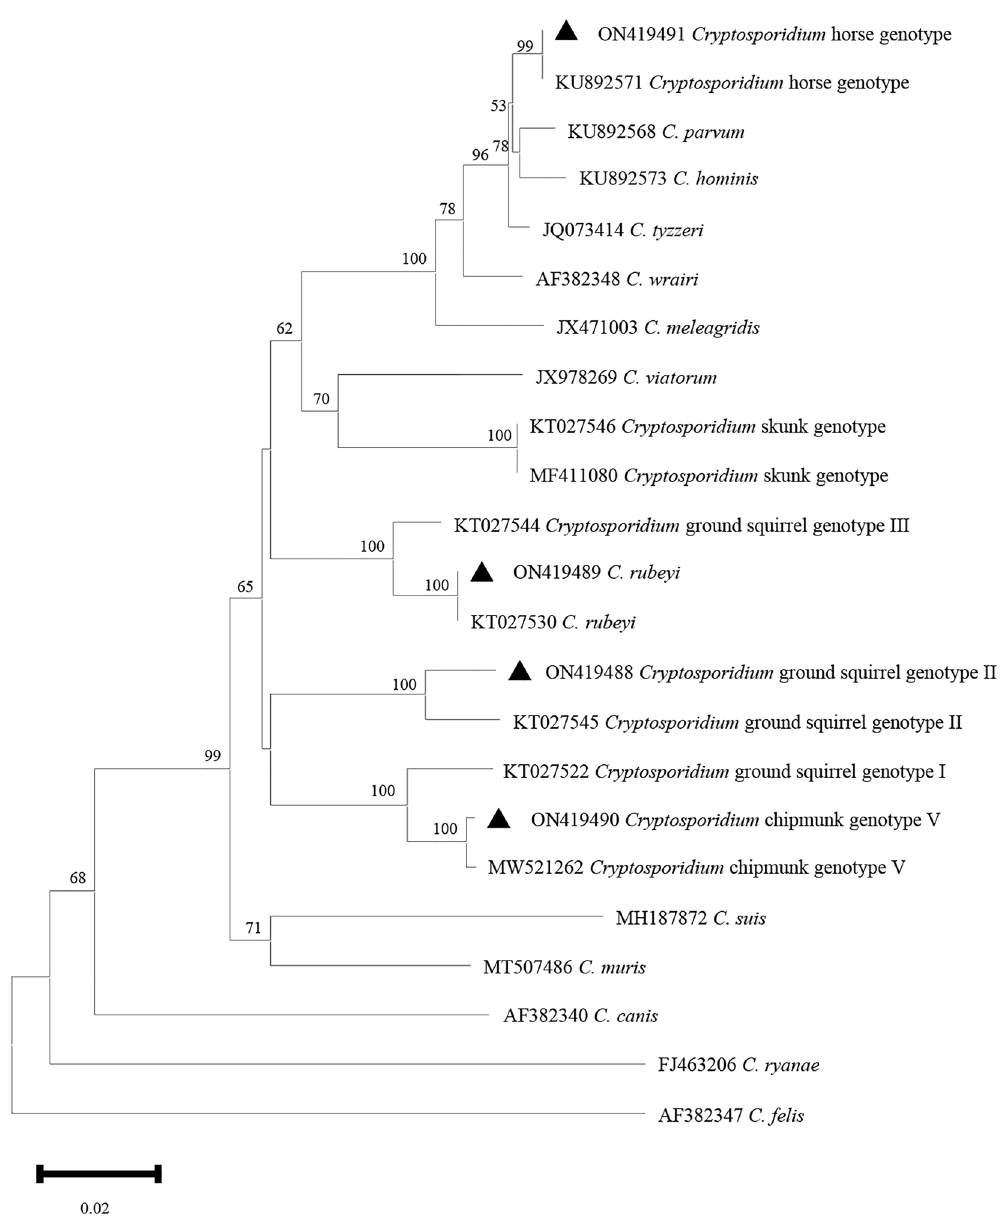
Figure 3. Phylogenetic relationship among Cryptosporidium spp. based on a neighbor-joining tree of the actin gene. The numbers on the branches are percent bootstrapping values from 1000 replicates, and the sequences generated in the present study are indicated with the